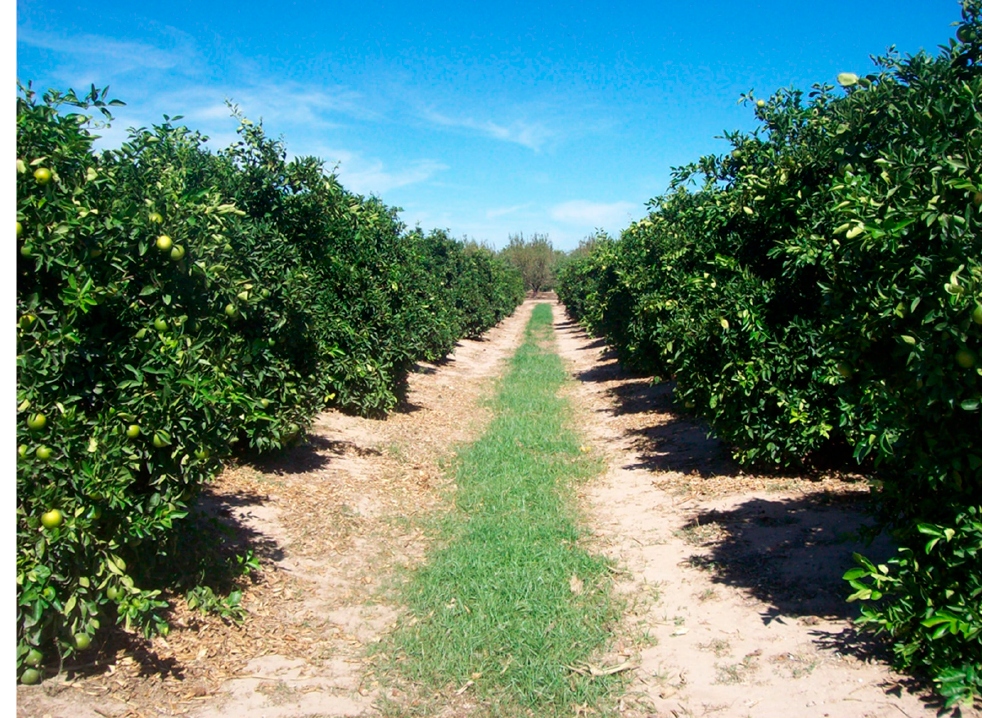
Figure 1. Overview of the experimental plot.